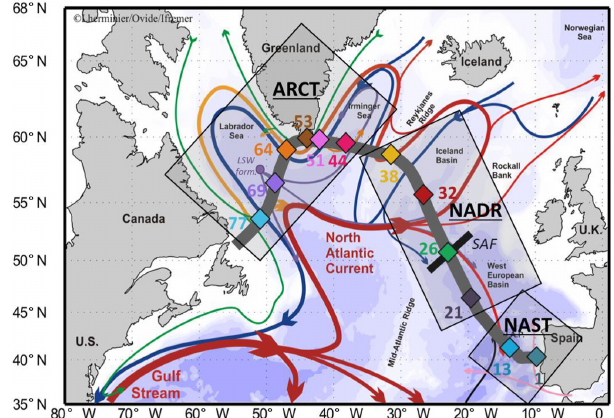
Figure 1. Map of the studied area (subpolar North Atlantic, SPNA), including schematized circulation features, adapted from García- Ibáñez et al. (2015). Bathymetry is plotted in color with interval boundaries at 100m, 1000m, and every 1000m below 1000m. Red and green arrows represent the main surface currents; pink and orange arrows represent currents at intermediate depths; blue and purple arrows represent the deep currents. Diamonds indicate sta- tion locations in three distinct areas (grey squares): the North At- lantic Subtropical province (NAST), the North Atlantic Drift Re- gion (NADR), and the Arctic region (ARCT). The approximate lo- cations of the subarctic front (SAF; black bar crossing station no. 26) and the formation site of the Labrador Sea Water (LSW form.) are also indicated. The section used in ODV figures is symbolized by the thick grey line. From Lemaitre et al.